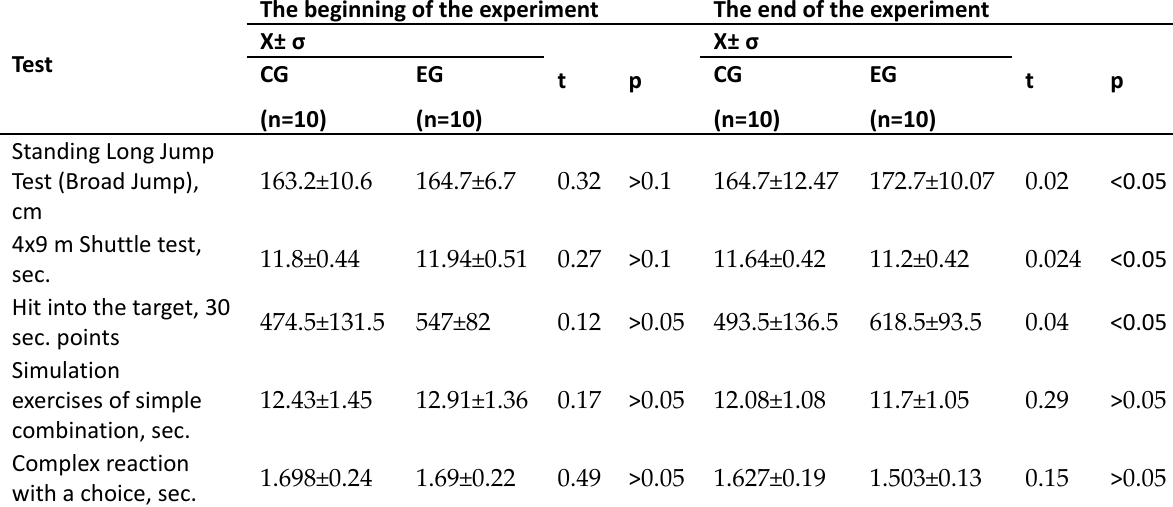
Table 1. Comparison of the dynamics of indicators of physical training under the influence of the program in CG and EG